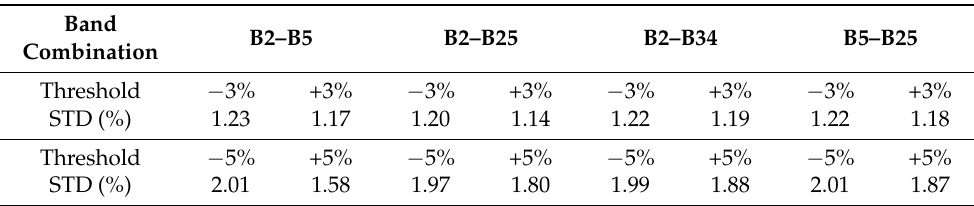
Table 3. Comparison of the MPF variations for the 4 band combinations with threshold variations of ± 3% and ± 5% for 6 overlapping areas.